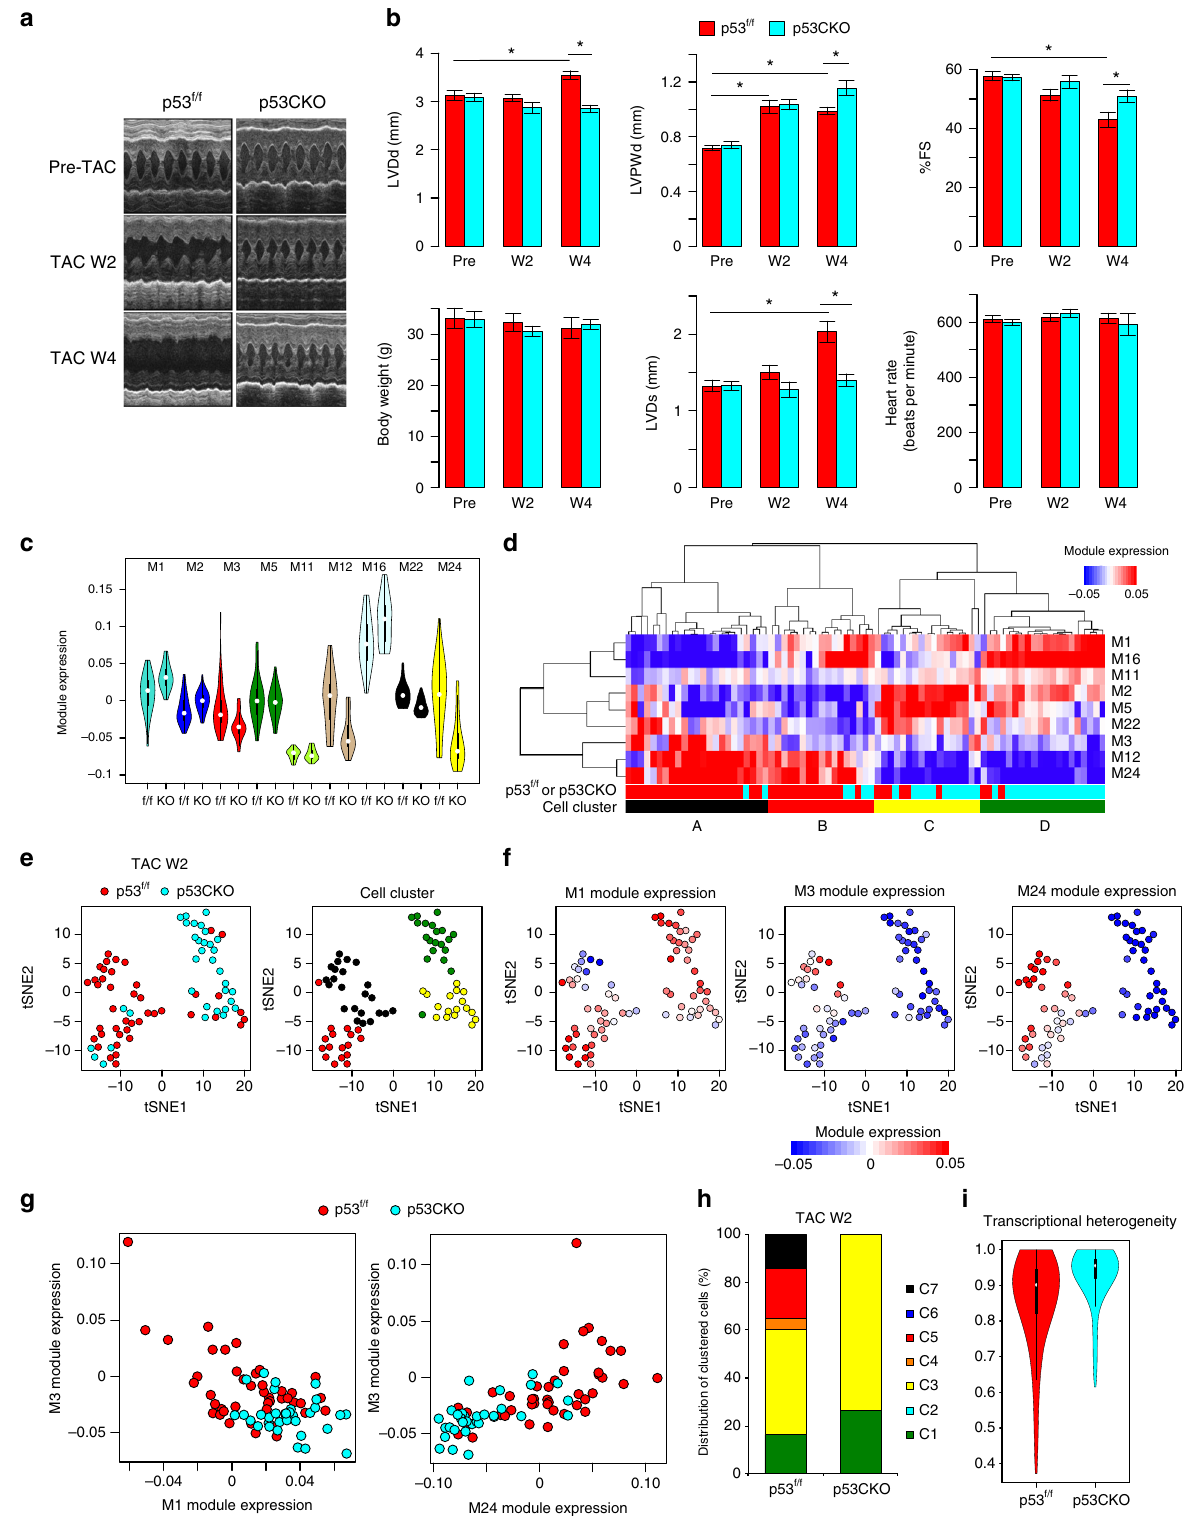
(Fig. 6a). Single-cardiomyocyte RNA-seq validated the hetero- geneous downregulation of these genes in p53CKO cardiomyo- cytes (Fig. 6b). Epigenomic pro fi ling of murine cardiomyocytes in the heart failure stage revealed the enrichment of binding motifs of myocyte enhancer factor-2 (MEF2) and nuclear